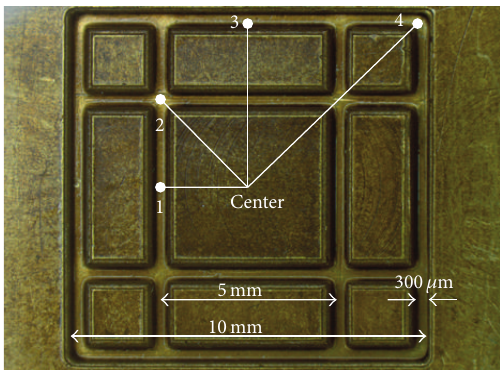
Figure 6: The copper mold with square patterns.